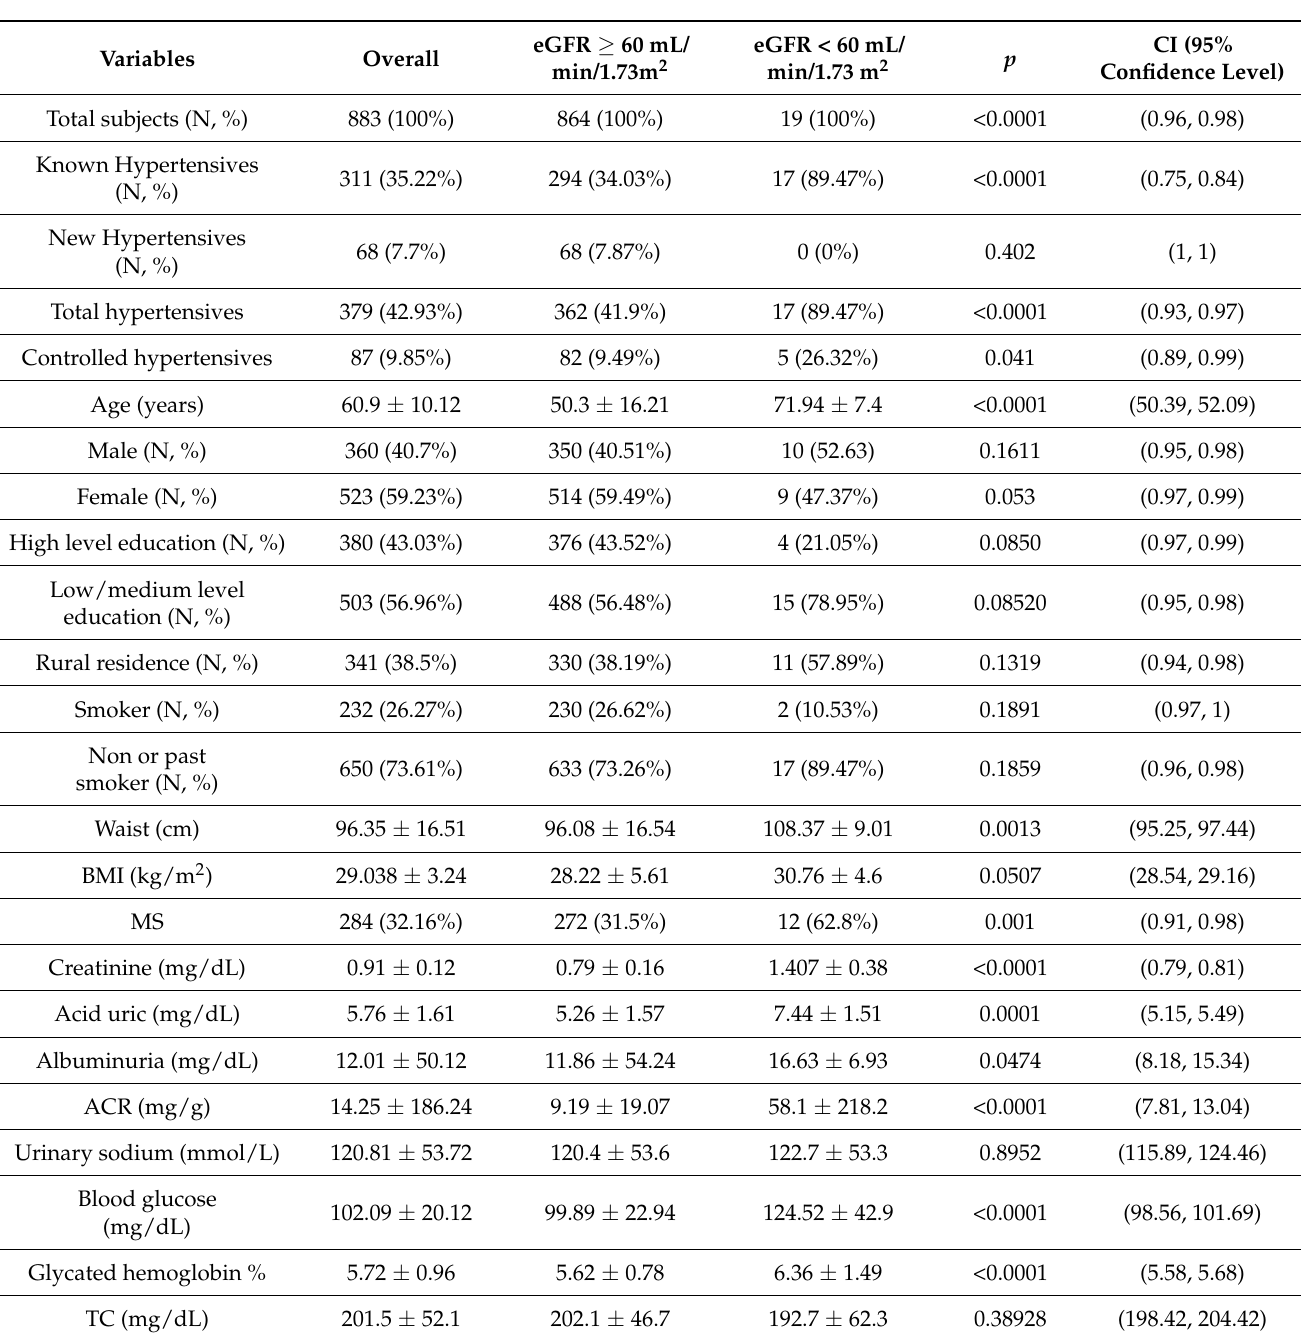
Table 1. Characteristics of the hypertensive and non hypertensive individuals according to